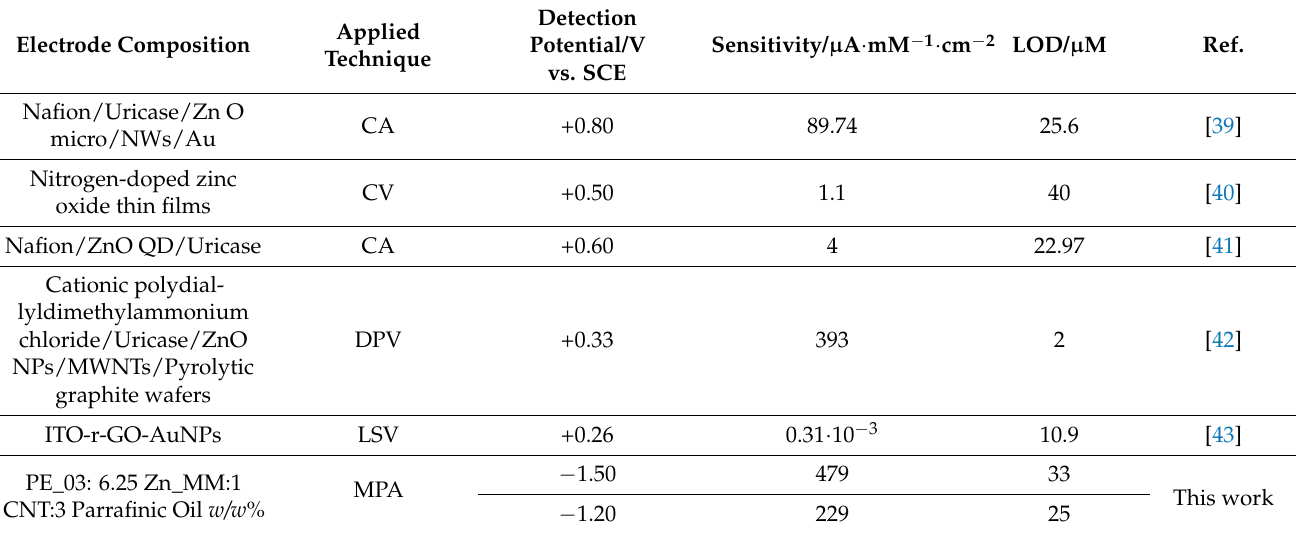
Table 4. Comparison of the electroanalytical performance of PE_03 with reported electrochemical sensors for UA